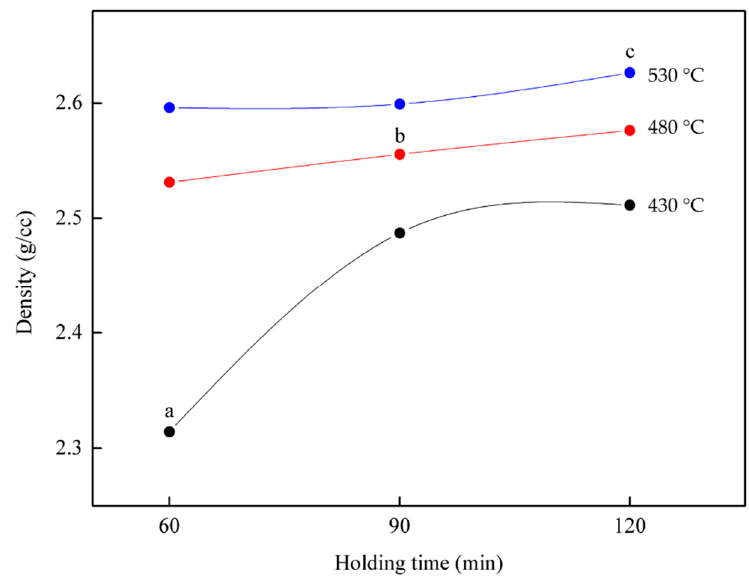
Figure 9. Density variation at different temperatures.